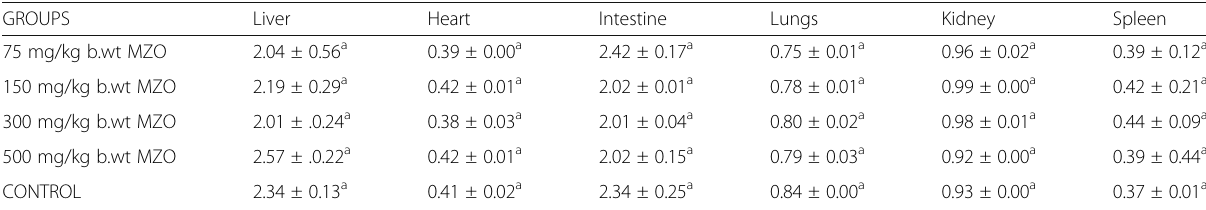
Table 9 Relative organ weight ratio of rats administered methanol extract of Zingiber officinale